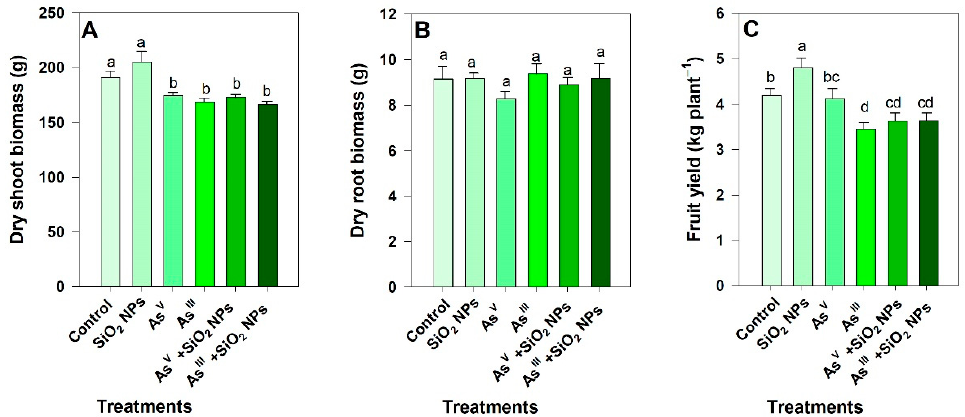
Figure 1. Effect of two forms of inorganic As (As V -As III ) and SiO 2 NPs on the growth and yield of tomato plants. ( A ) Dry shoot biomass, ( B ) dry root biomass, and ( C ) fruit yield. Plants treated with 3.2 mg L − 1 of As V (Na 2 HAsO 4 ∙ 7H 2 O) and As III (NaAsO 2 ) via irrigation through the nutrient solution and 1000 mg L − 1 of SiO 2 NPs via substrate. Different letters per bar indicate significant differences according to the Fisher’s least significant difference test ( p ≤ 0.05). n = 5 ± standard error.